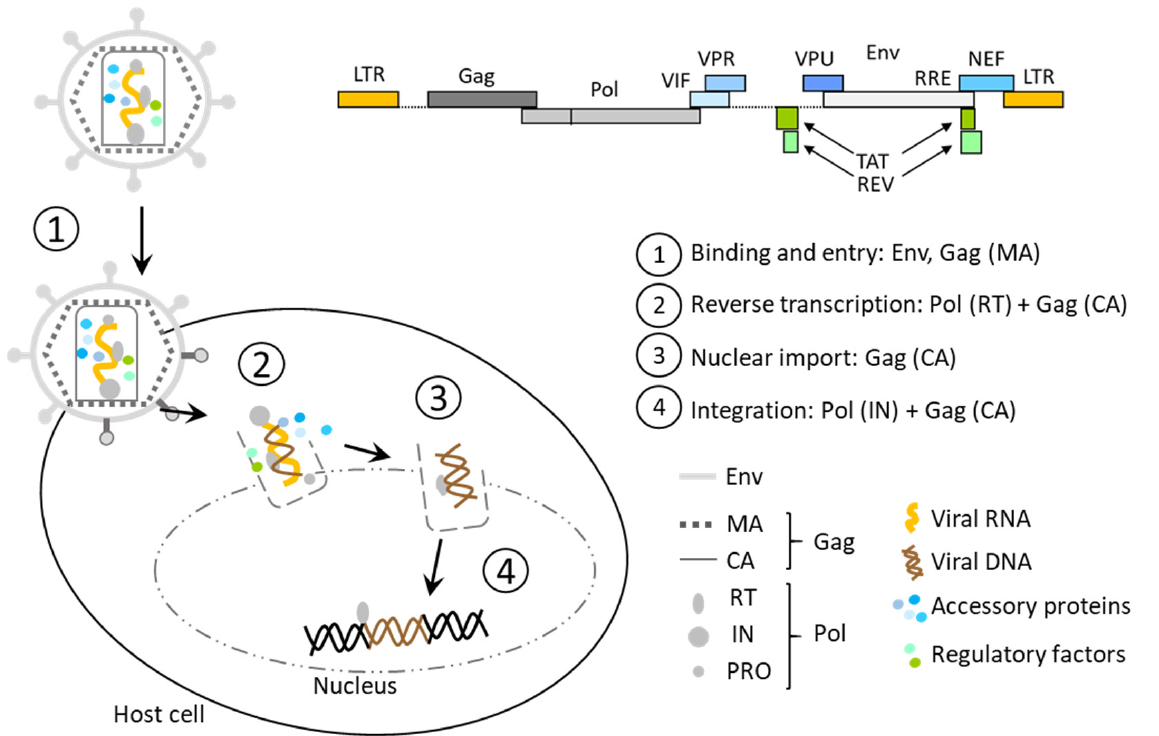
Figure 1. The uncoating of the capsid is still not clear as CA was shown to influence reverse transcription, nuclear import, and provirus integration [11].